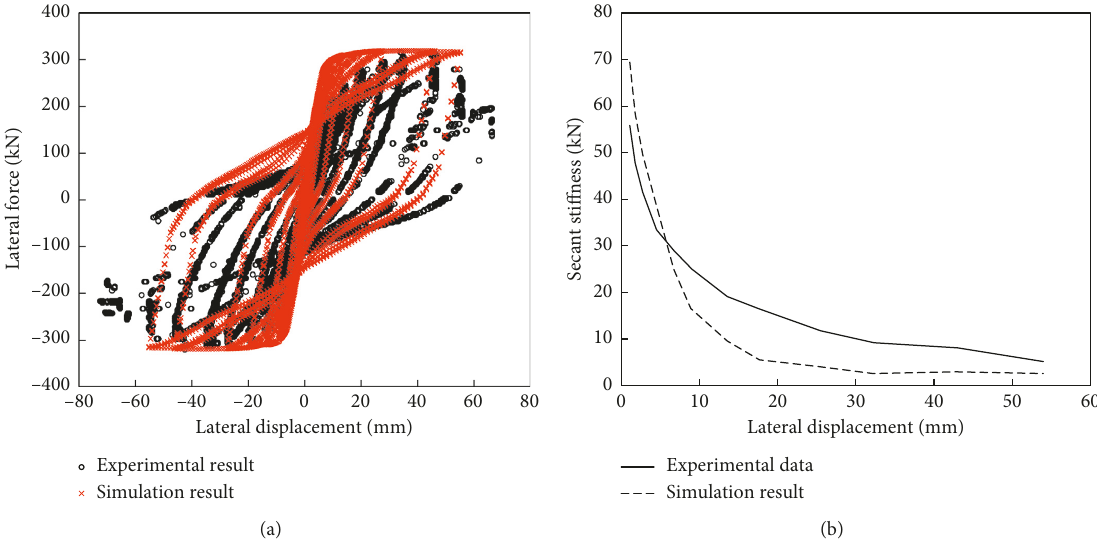
Figure 21: The result of hysteretic analysis and nonlinear pushover analysis